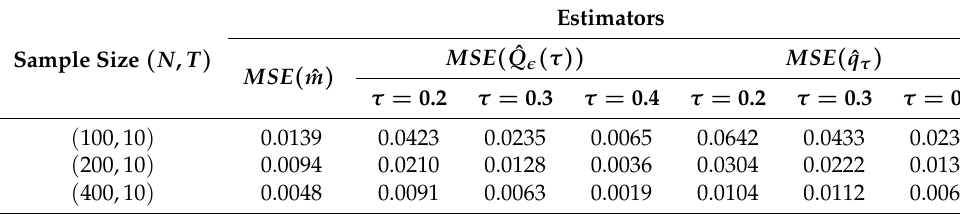
Table 2. Mean MSE ( × 100), t ( 3 )